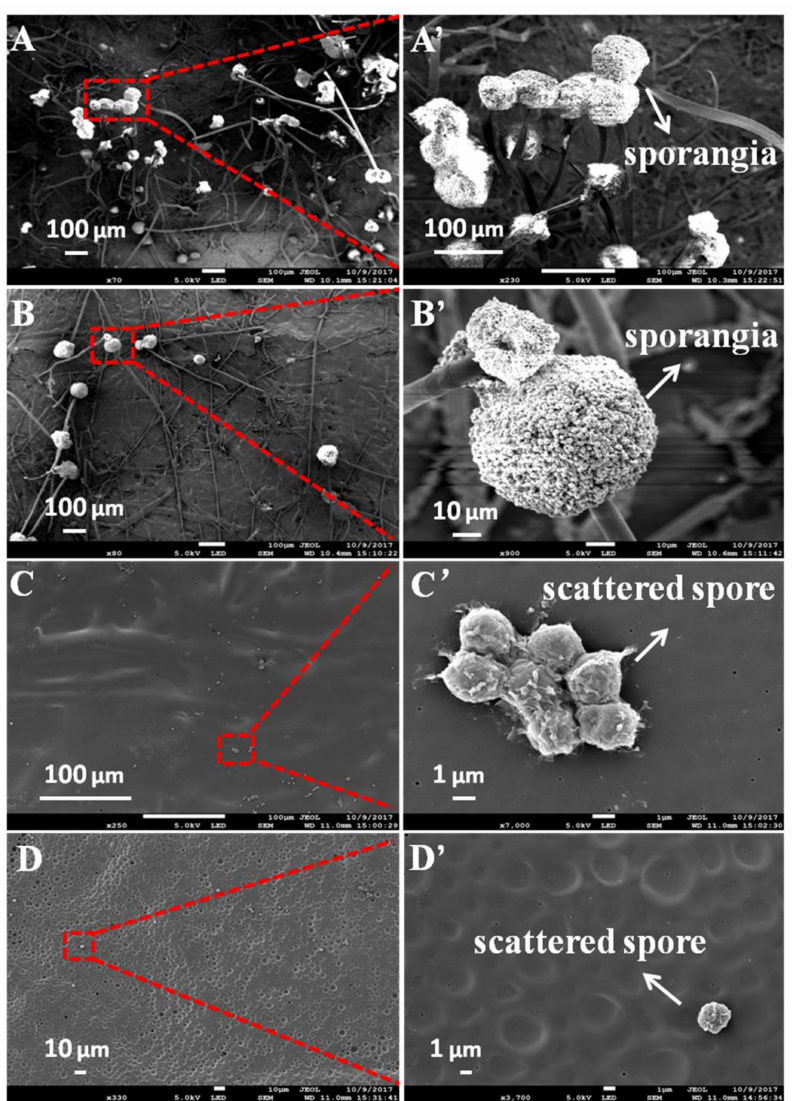
Figure 4. SEM images of A. niger cells on papers coated with 0 ( A , A’ ), 5 ( B , B’ ), 10 ( C , C’ ) and 15% ( D , D’ ) of PBA after incubating for eight days. The images of ( A’ – D’ ) show zoomed-in views of areas in the corresponding images of ( A – D